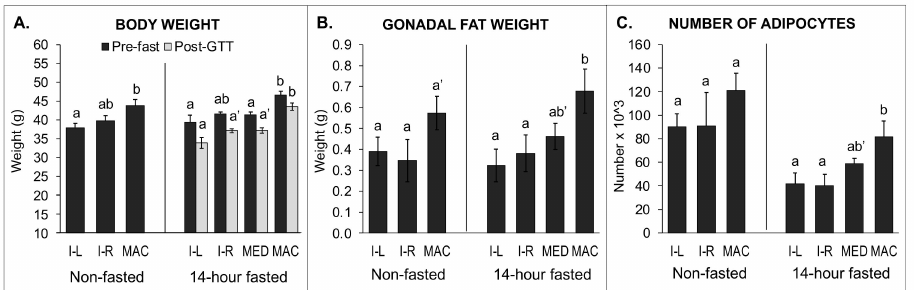
Figure 6. Comparison of body weight, fat pad weights, and adipocyte number in non-fasted vs. 14-h fasted animals. Data are from non-fasted males (IUGR-L n = 4, IUGR-R n = 5 and macrosomic n = 5) that did not undergo a GTT, and males fasted for 14 h prior to GTT and fat pad collection (IUGR-L n = 5, IUGR-R n = 8, median n = 14, macrosomic n = 13). ( A ) body weights, ( B ) gonadal fat pad weights, and ( C ) the number of adipocytes per total mass of fat. Groups with different letters are significantly different from each other; groups that share a letter in common are not statistically different; a’ and b’ p < 0.1. Values are mean ± SEM.